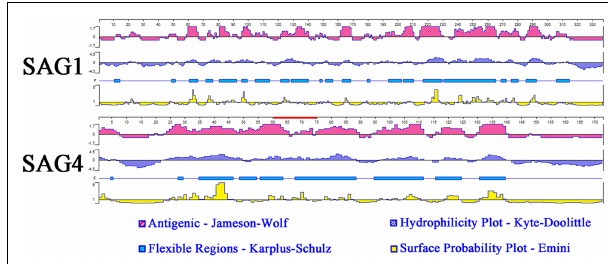
FIGURE 1 | The linear-B cell epitopes of SAG1 and SAG4 predicted by DNASTAR in antigenic index, hydrophilicity plots, flexible regions, and surface probability rules. The red line on SAG4 was the position of peptide 61-75 (SRPLEYIPPNPSQVL) used in this study. The prediction was run for three